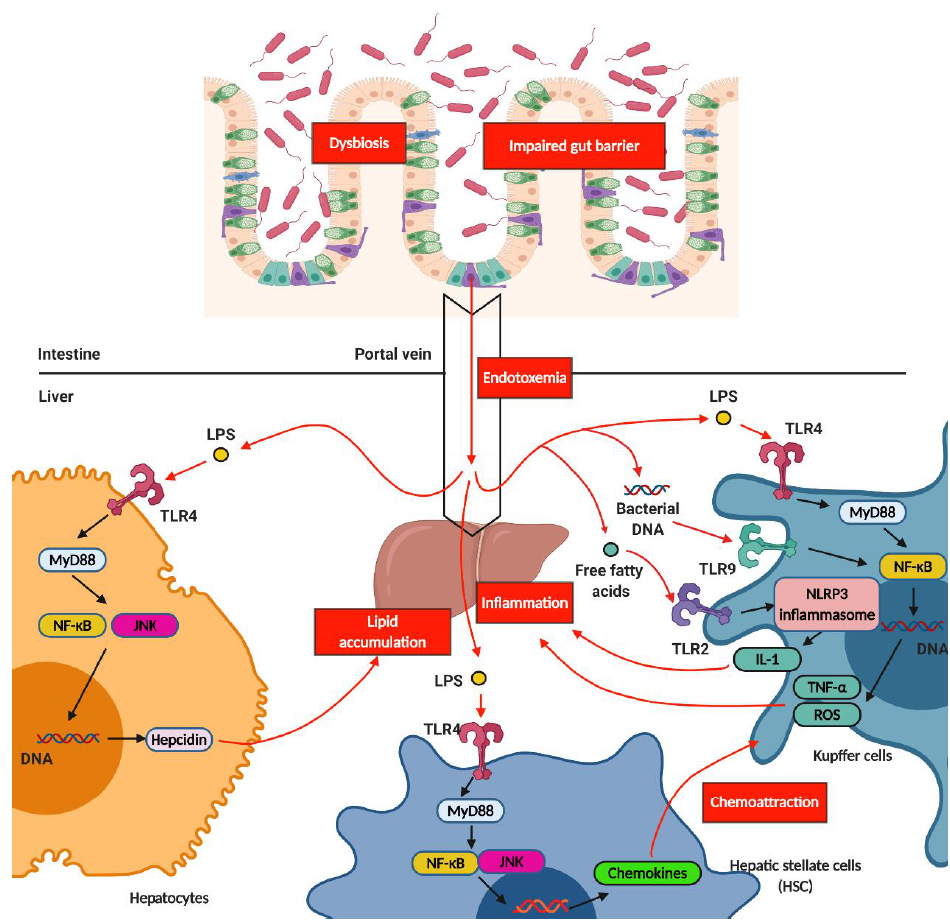
Figure 3. The mechanism of hepatic inflammation induced by gut microbiota. Dysbiosis results in impaired gut barrier and further induces the influx of bacterial DNA and LPS, which is termed endotoxemia, from gut to liver through portal vein. LPS further triggers TLR4 signaling in hepatocytes, Kupffer cells, and hepatic stellate cells (HSC). Activation of TLR4 and TLR9 in Kupffer cells induces the production of TNF- α and ROS, which further contributes to hepatic inflammation. Activation of TLR4 in hepatocytes induces the production of hepcidin, which further induces hepatic lipid accumulation. Activation of TLR4 in HSC induces the production of chemokines, which further contributes to chemoattraction for Kupffer cells. Additionally, influx of free fatty acid from gut to liver activates TLR2 signaling, which is termed lipotoxicity. Activation of TLR2 signaling results in activation of NLRP3 inflammation, which induces the production of IL-1. Increased IL-1 production leads to hepatic inflammation. LPS, Lipopolysaccharide; MyD88, myeloid differentiation primary response 88; NF- κB, nuclear factor kappa -light-chain-enhancer of activated B cells; JNK, c-Jun N-terminal kinase; TLR, toll-like receptors.